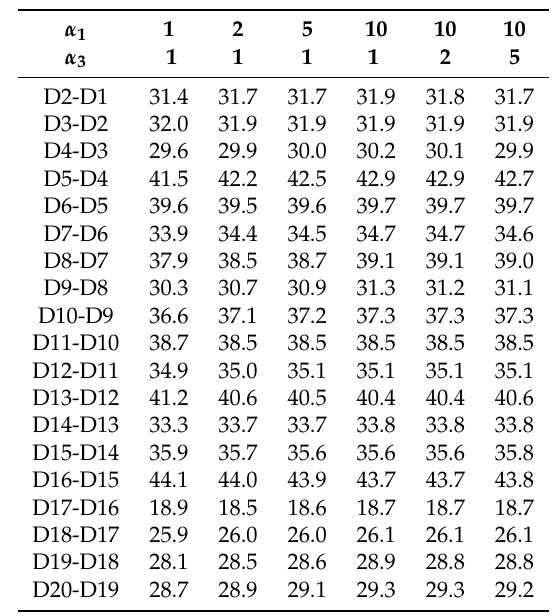
Table 6. Total headway deviations for trains